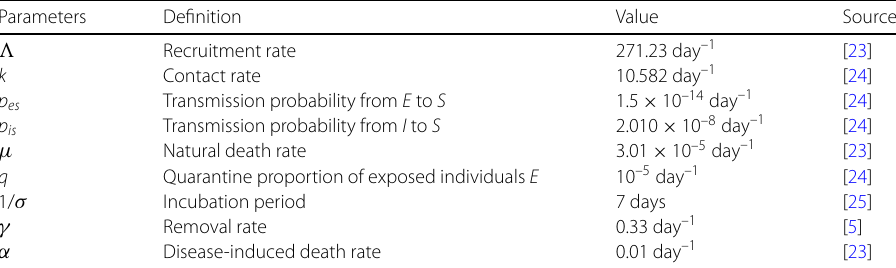
Table 1 Definition and values of model parameters